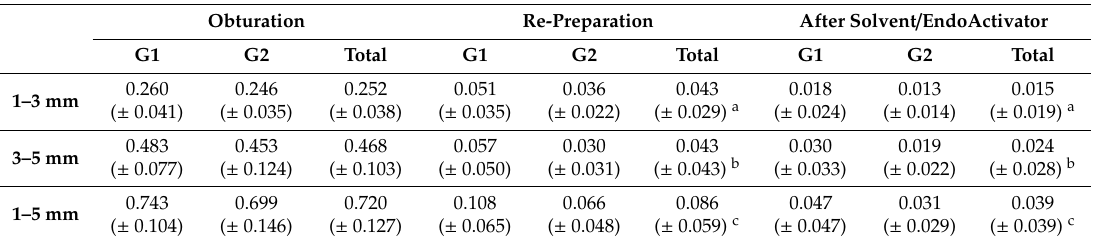
Table 1. Volume (mm 3 ) of filling material in different sections (1–3 mm and 3–5 mm) of the apical